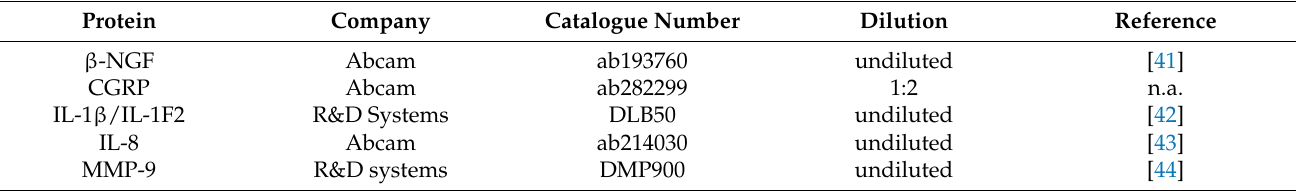
Table 7. Applied ELISA assays including company, catalogue number, dilution, and references. Abbreviations: CGRP = calcitonin gene-related peptide; IL = interleukin; MMP-9 = matrix metallo- proteinase-9; NGF = nerve growth factor.